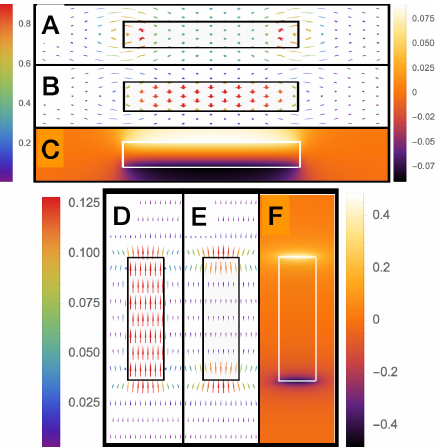
Figure 3. Not to scale field and potential plots for a cylindrical dipole. ( Above ) AR = 10: ( A ) 2D (cid:126) D T vector plot of the normalized electric flux density at y = 0, in the ( r − z ) plane, calculated from σ i e (cid:126) E Equations (37) and (38); ( B ) 2D vector plot of the normalized electric field (cid:101) at y = 0, in the ( r − z ) σ i e plane, calculated from Equation (34); ( C ) 2D colour density plot of the normalized electric scalar potential (cid:101) V at y = 0, in the ( r − z ) plane, calculated from Equation (30). ( Below ) similar plots to σ i e (cid:126) D (cid:126) E T ( above ) but with AR = 0.1: ( D ) at y = 0, in the ( r − z ) plane; ( E ) (cid:101) at y = 0, in the ( r − z ) plane; σ i e σ i e ( F ) (cid:101) V at y = 0, in the ( r − z ) σ i e